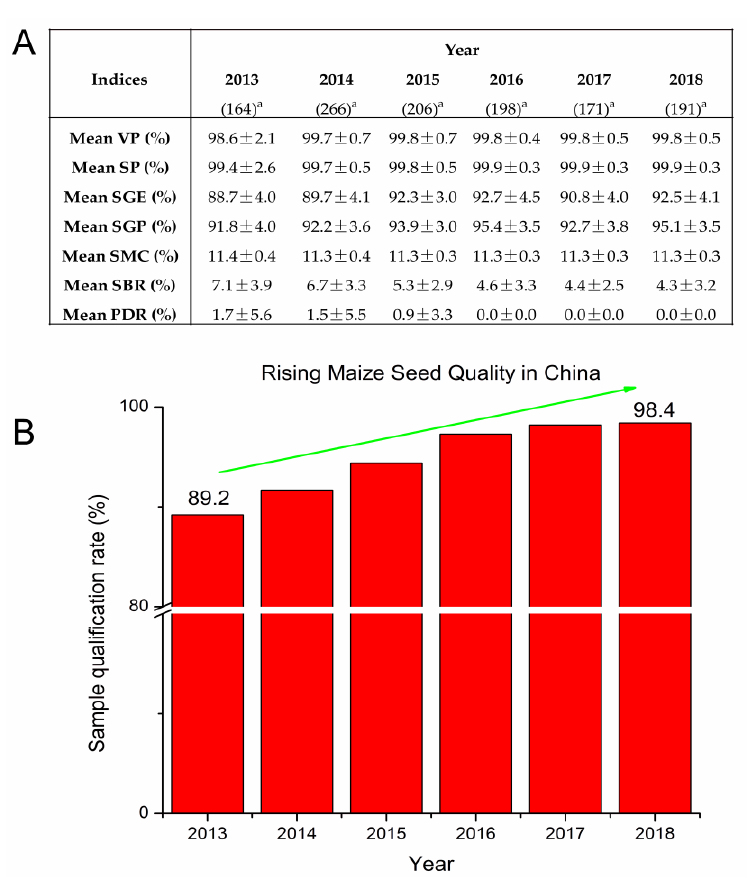
Figure 3. Comparison analysis of mean values of varietal purity (VP), seed purity (SP), standard germination energy (SGE), standard germination percentage (SGP), seed moisture content (SMC), seed breakage rate (SBR), pest damage rate (PDR) ( A ), and sample qualification rate (namely the percentage of samples which met the prescribed quality standards) ( B ) from 2013 to 2018. a The annual numbers of samples; from 2013 to 2018, the annual numbers of samples were 164, 266, 206, 198, 171 and 191, respectively.